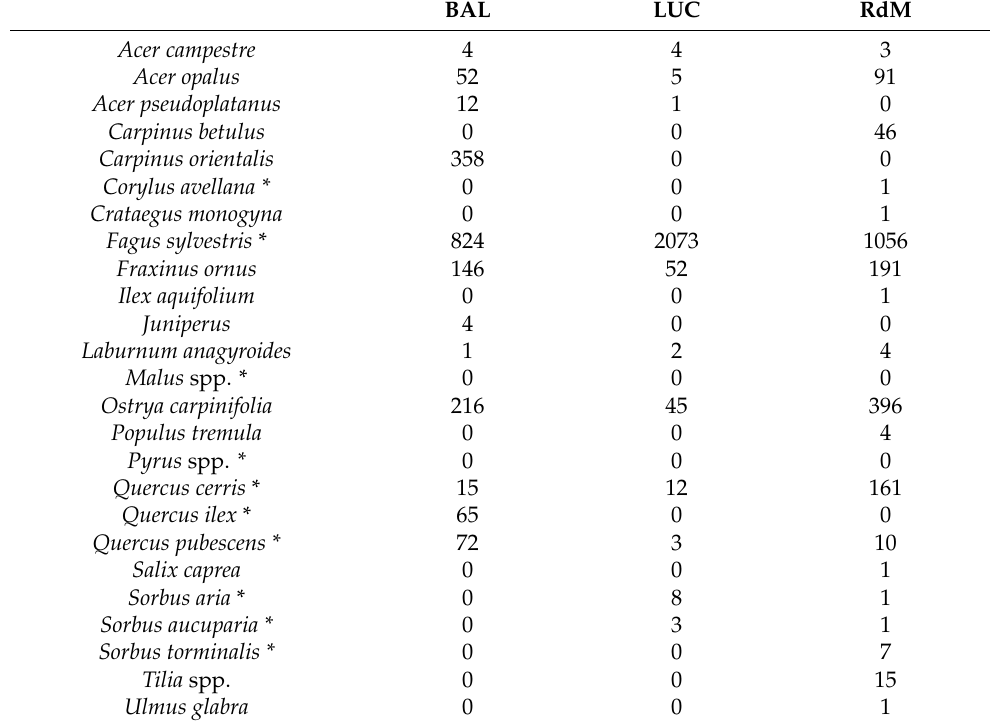
161 Quercus ilex * 65 0 0 72 3 10 0 0 1 0 8 1 Sorbus aucuparia * 0 3 1 Sorbus torminalis * 0 0 7 Tilia spp. 0 0 15 Ulmus glabra 0 0